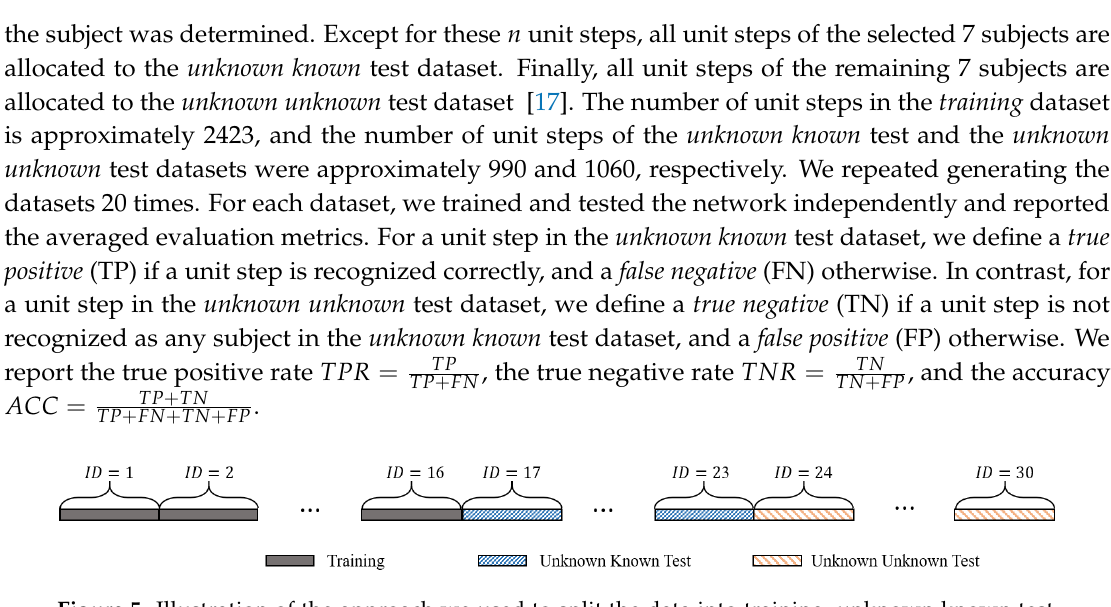
Figure 5. Illustration of the approach we used to split the data into training, unknown known test, and unknown unknown test